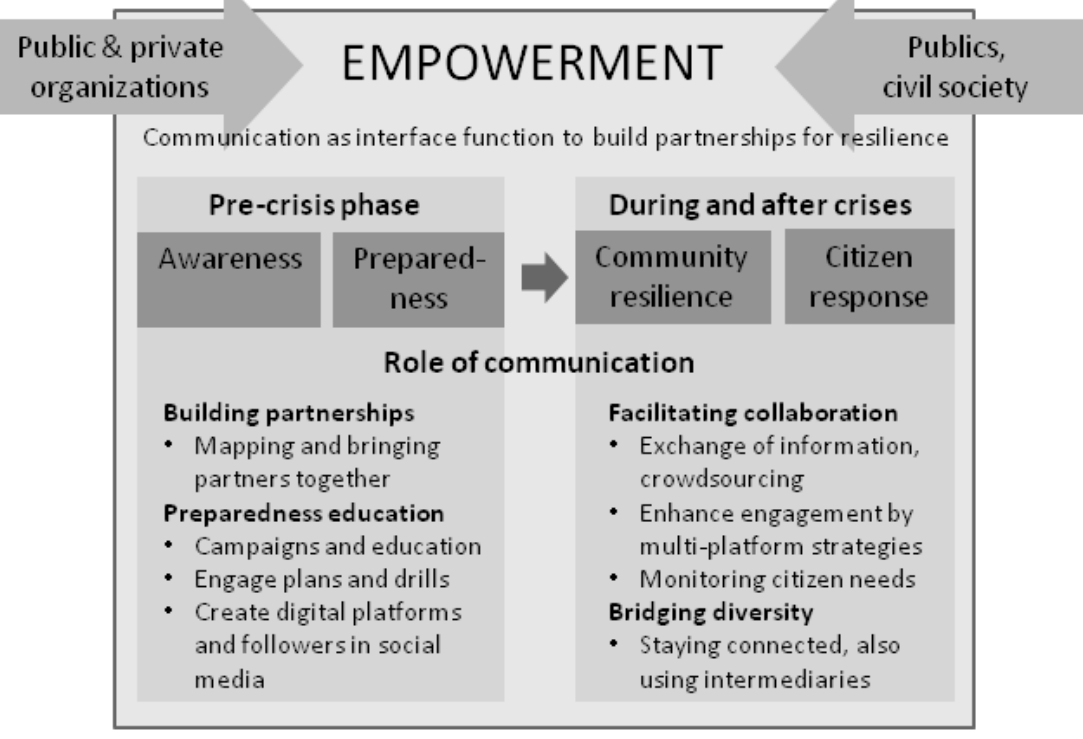
Figure 1. Communication facilitating community